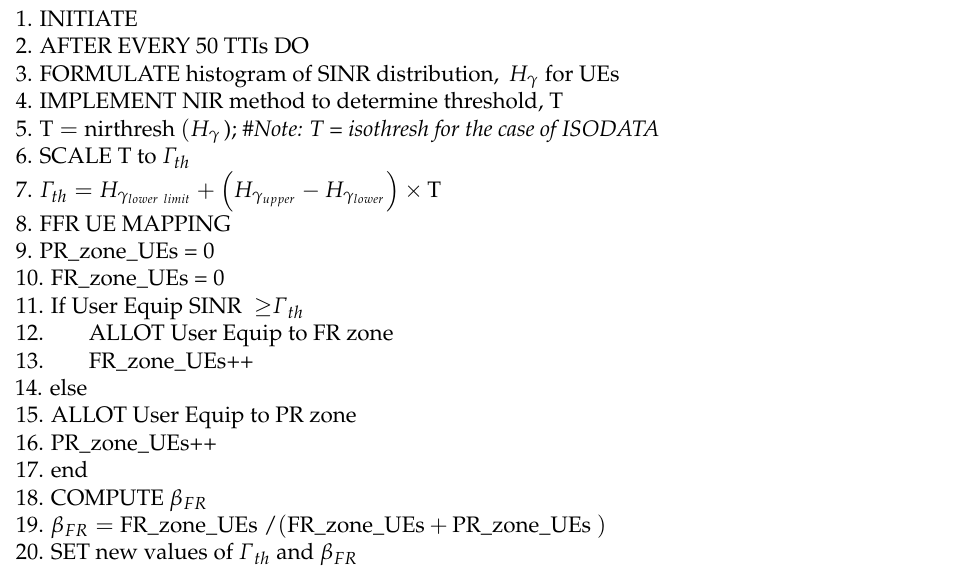
Table 2. System algorithm for optimal thresholding and frequency allocation for NIR.